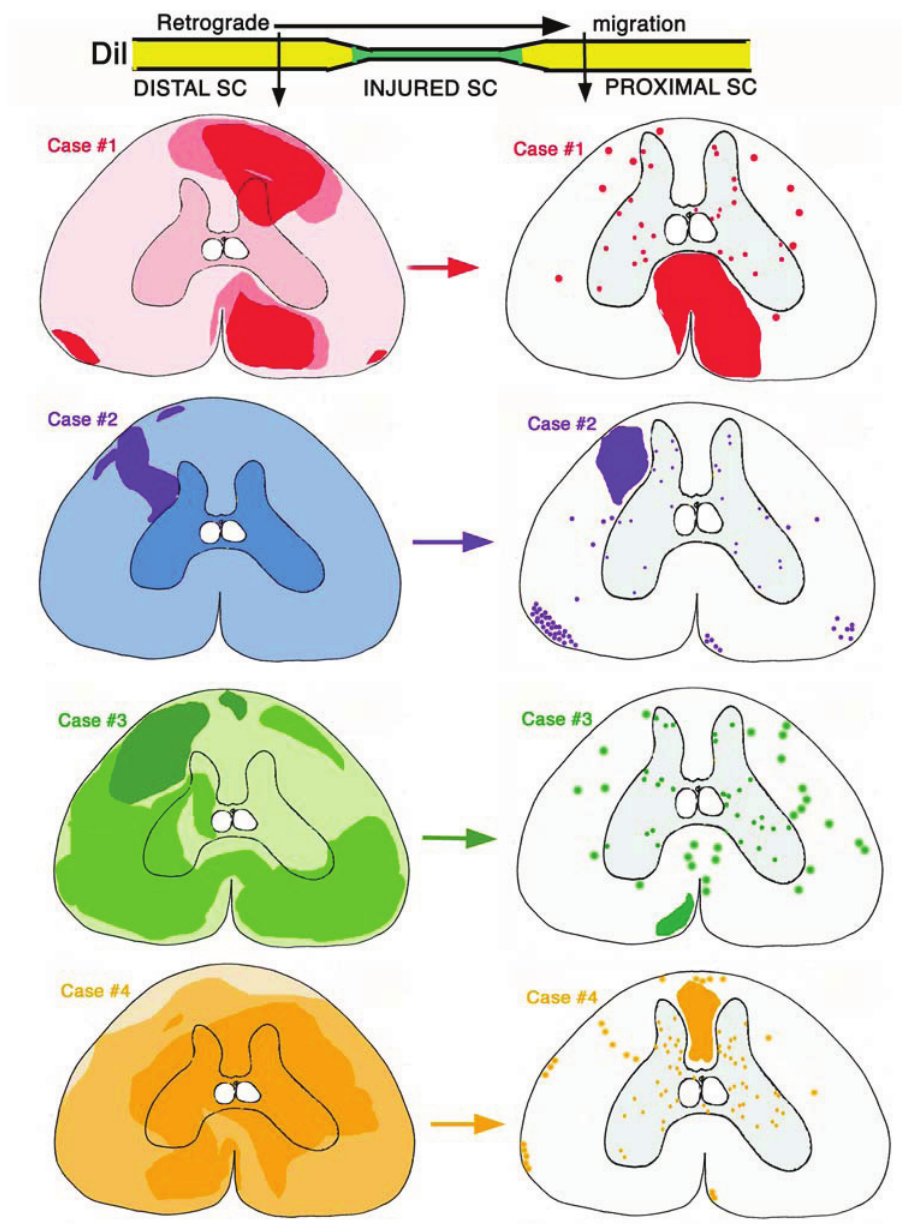
Figure 9. Schematic drawing showing the total of the labeling results (neurons within the grey matter and labeled fibers in the white matter) in the four cases studied. On the left is shown the distribution of the tracer in the distal spinal cord where the tracer was placed, and the color intensity roughly indicate the intensity of the labeling. On the right column are indicated the position of all the counted labeled neurons (smaller dots within the grey matter) and axons-fibers (larger dots within the white